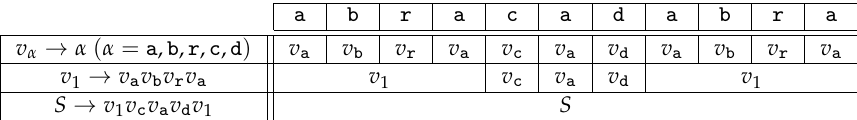
a , b , r , c , d a , v b b , v r r , v c v a , , S , } { } { → → →